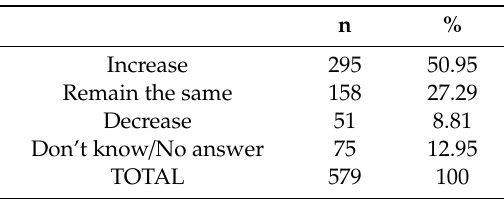
Table 3. In the next coming years, aquaculture